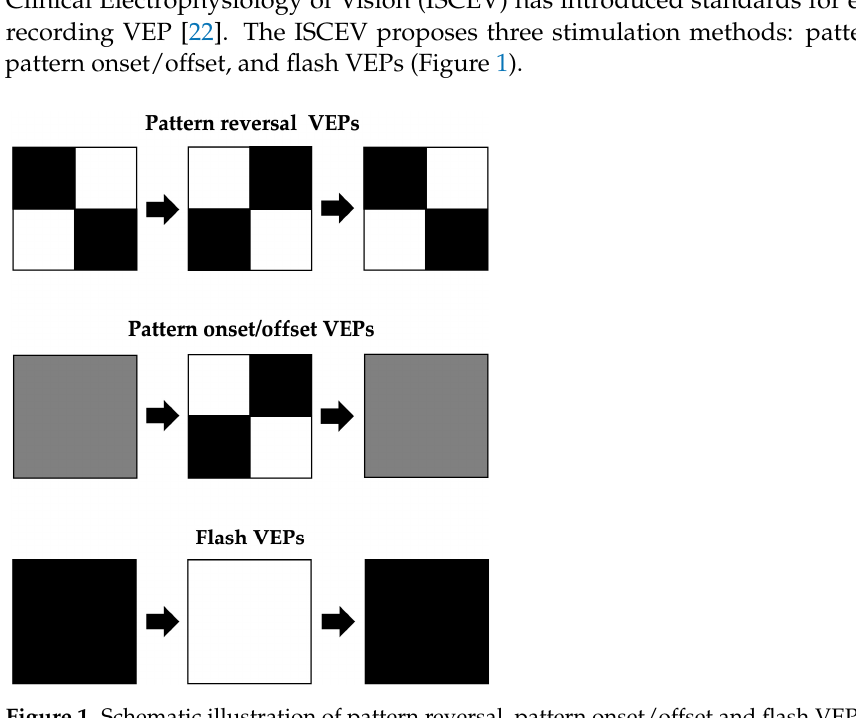
Figure 1. Schematic illustration of pa tt ern reversal, pa tt ern onset/o ff set and fl ash VEPs stimuli. Pa tt ern reversal VEPs are elicited by checkerboard stimuli with large, 1° (acceptable range of 0.8° to 1.2°), and small, 0.25° (0.2° to 0.3°), checks. Pa tt ern reversal VEP has less variation in waveforms and latencies due to individual di ff erences between subjects than VEP using other stimulation conditions and has excellent reproducibility. A typical